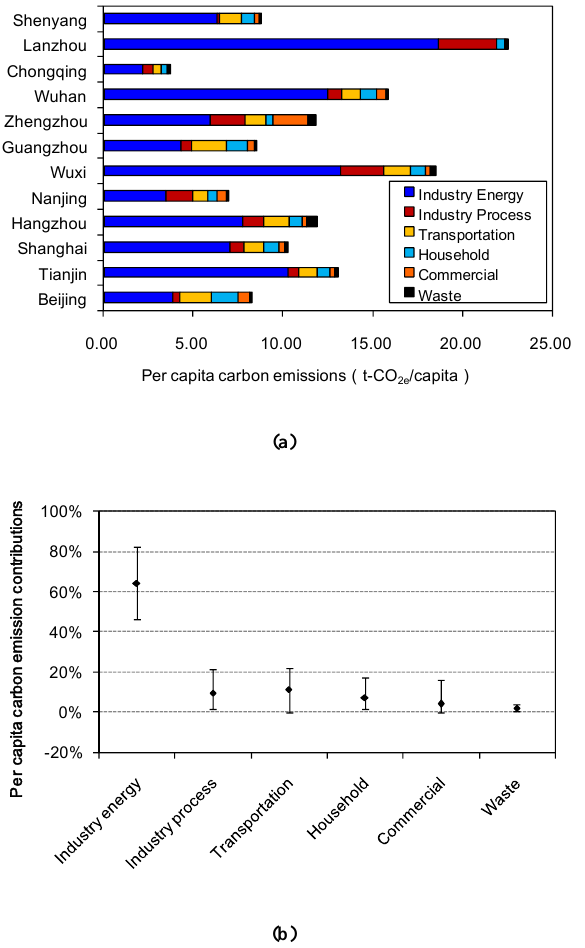
Fig. 2. Per capita carbon emissions (ton CO 2e ) by sector for all 12 China’s cities in 2008: (a) individual city data of per capita carbon emissions; (b) sector contribution shares (mean and range values) across the 12 cities.